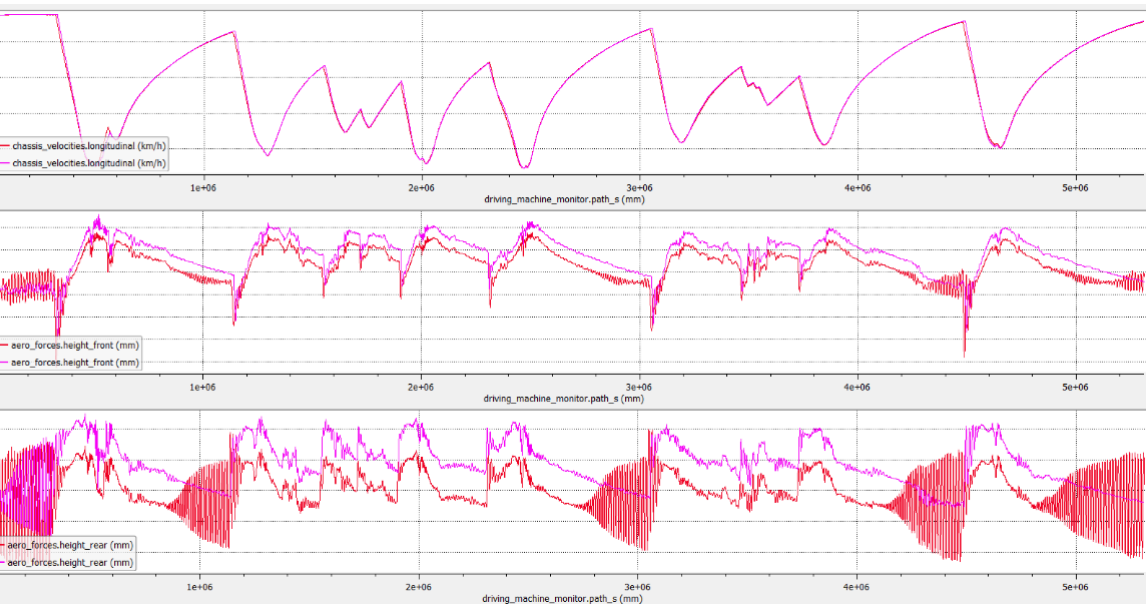
Figure 35. With Setup #3 porpoising is triggered just at the end of the straight, the downforce level however is higher on average. Top and mid plot are the front and rear downforce vs. lap distance, bottom plot is the vertical acceleration at the center of gravity.